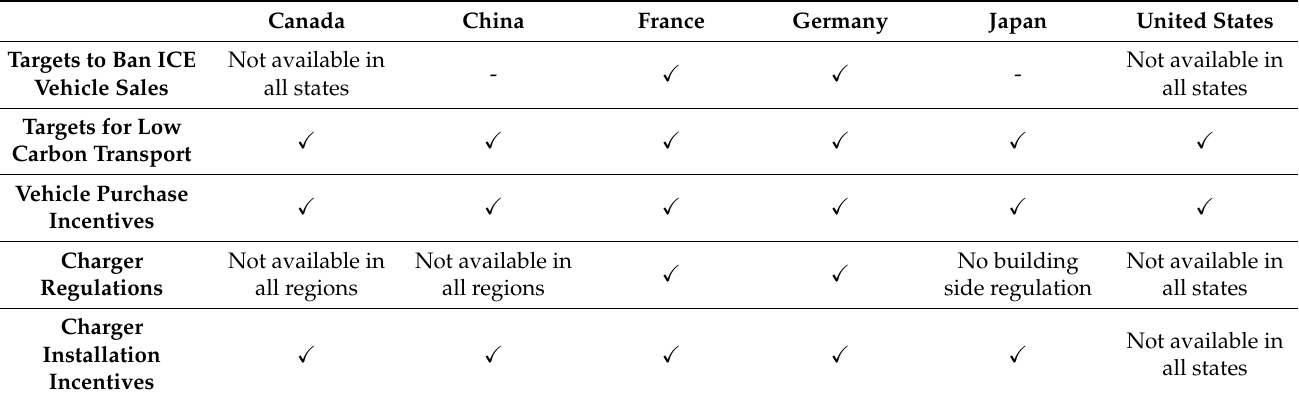
Table 3. EV incentives and regulations in some countries.